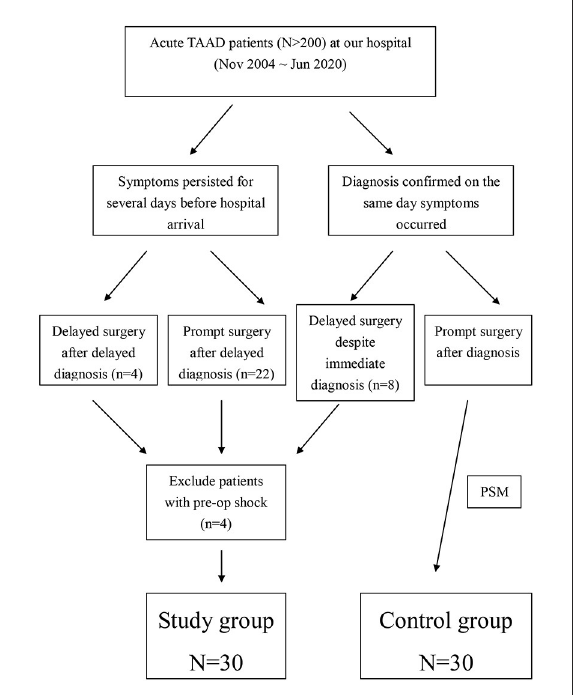
FIGURE1 Grouping of the study group and the control group. PSM, propensity score matching.